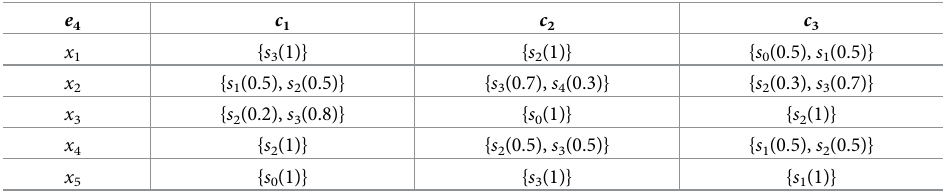
Table 4. The decision matrix of e 4 .